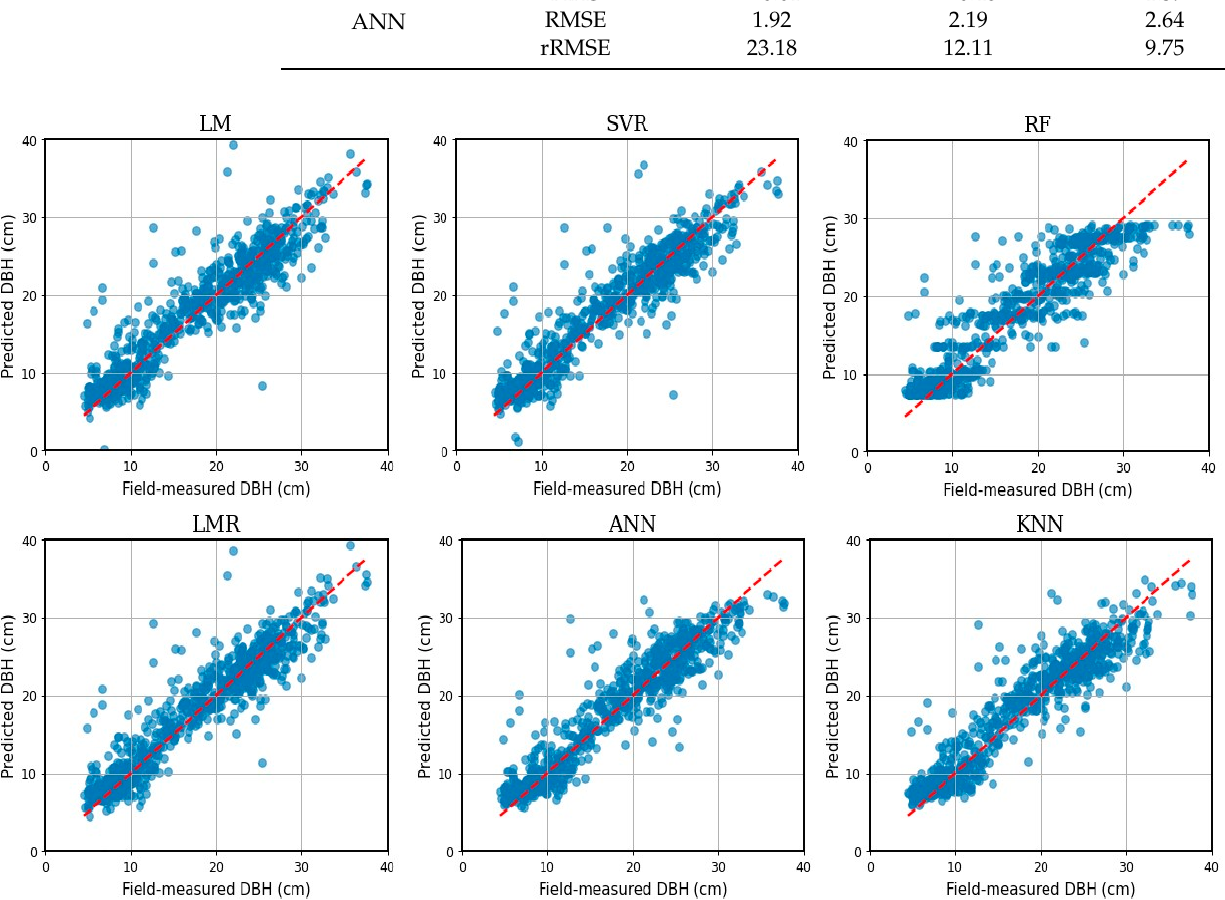
Figure 9. The predicted vs. field-measured diameter at breast height (DBH) in the independent validation data for six different prediction algorithms. The red line is the 1:1 trend line.